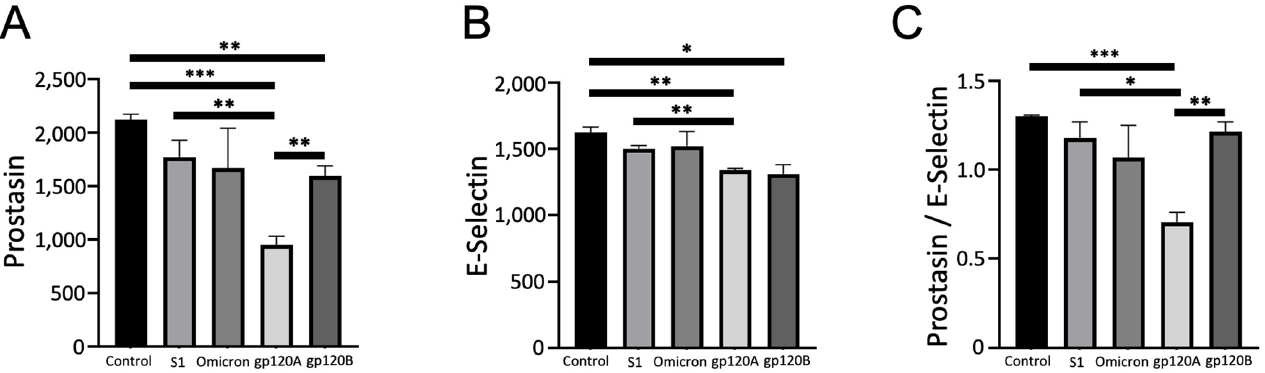
Figure 3. Characteristic of the effects of gp120 proteins of HIV-1 Group M Subtype A and Subtype B on the prostasin expression. Human pulmonary artery endothelial cells were treated with SARS-CoV-2 spike proteins S1, Omicron S1, and gp120 of HIV-1 Subtype A (gp120A) or Subtype B (gp120B) at 1 nM for 20 h in triplicate. Expression patterns of various proteins were monitored using R&D Human XL Oncology Array. Bar graphs represent means ± SEM (N = 3 for all groups) of ( A ) prostasin expression, ( B ) E-selectin expression, and ( C ) the ratio of prostasin to E-selectin expression. * p < 0.05. ** p < 0.01. *** p < 0.001. The y-axis indicates the mean pixel density of protein spots.